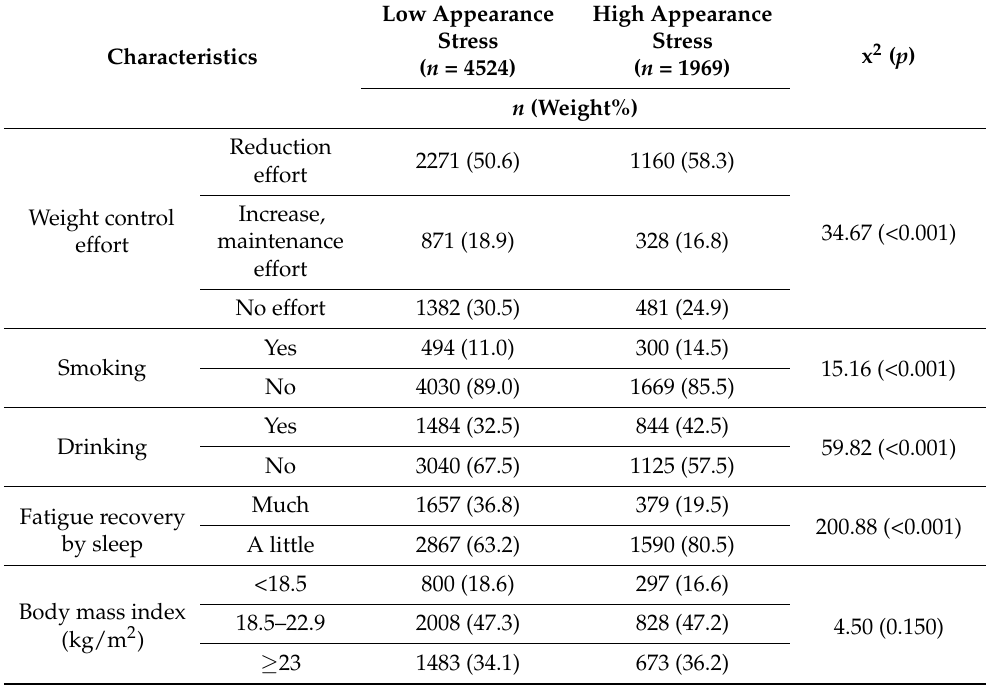
Table 3. Health related factors ( n =